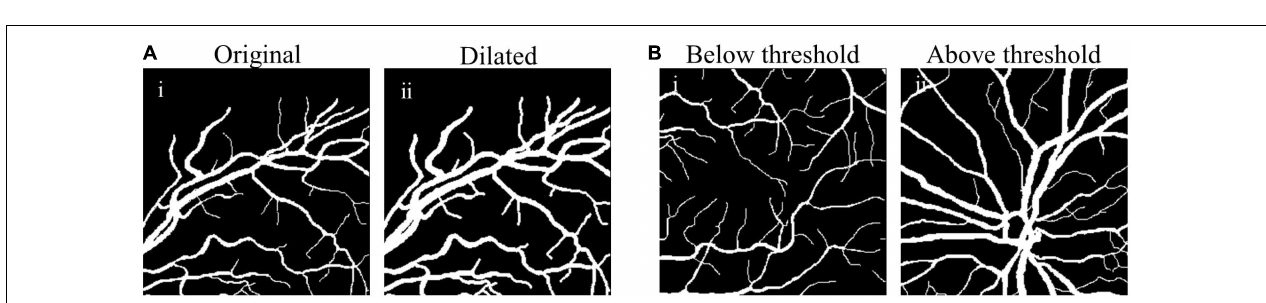
FIGURE 3 | Examples of size-matching strategies in source domain. (A) The original fundus image (A-i) was transformed to the dilated image (A-ii) after the size matching method by vessel dilation (vdSM), and (B) in the size matching method by patches selection (psSM), the fundus image with the proportion of vessel pixels below threshold (B-i) was removed from the source domain, while that with more thick vessels (B-ii) was reserved.